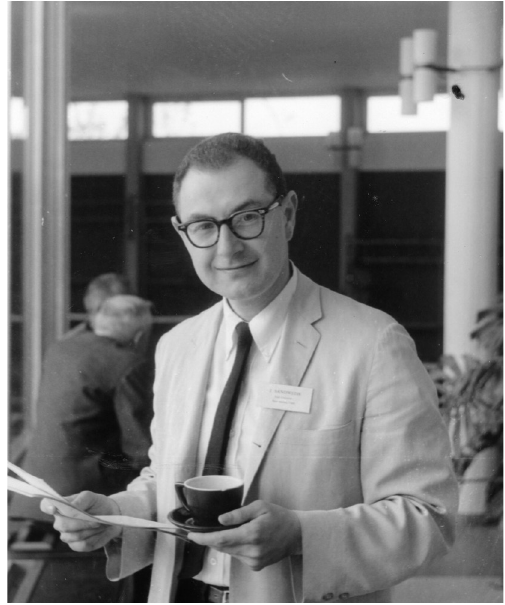
Figure 1. Jack at CERN. AIP Emilio Segre Visual Archives, Segre Collection